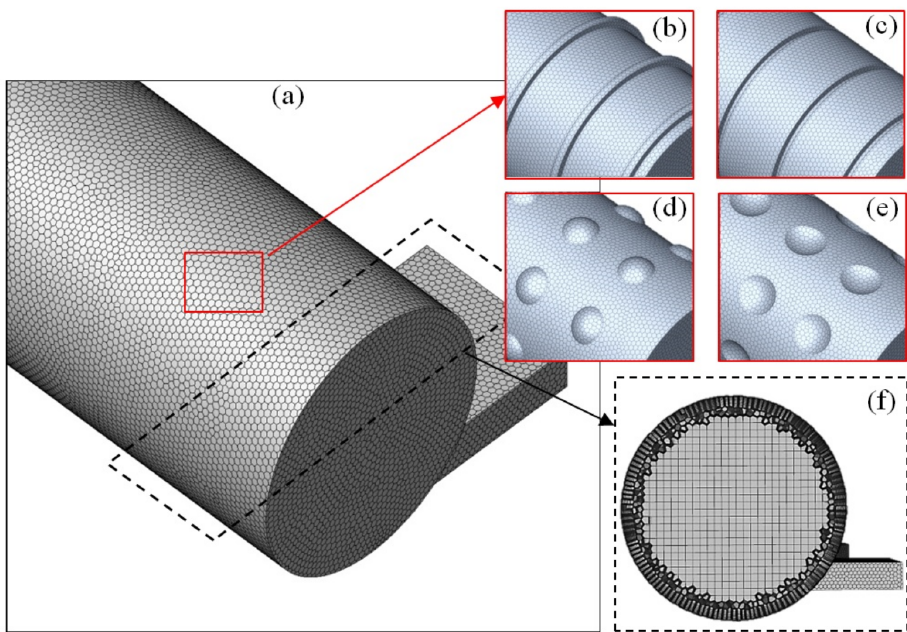
Figure 4. Schematics of the mesh for computations: ( a ) Smooth tube; ( b ) Trench tube; ( c ) Rib tube; ( d ) Dimple tube; ( e ) Bulge tube; ( f ) Cross